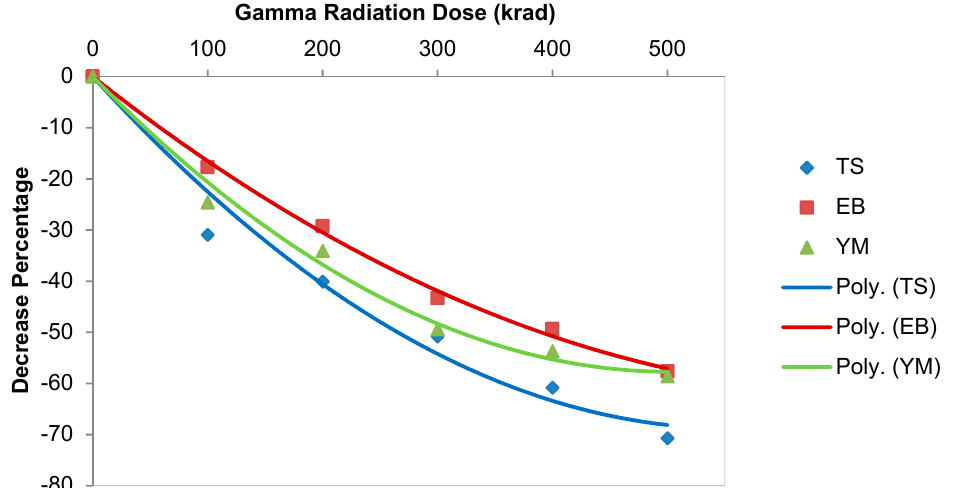
Figure 2. Gamma radiation effects on the tensile strength (TS), elongation at break % (Eb%), and Young’s modulus (Y) of the jute fabric.